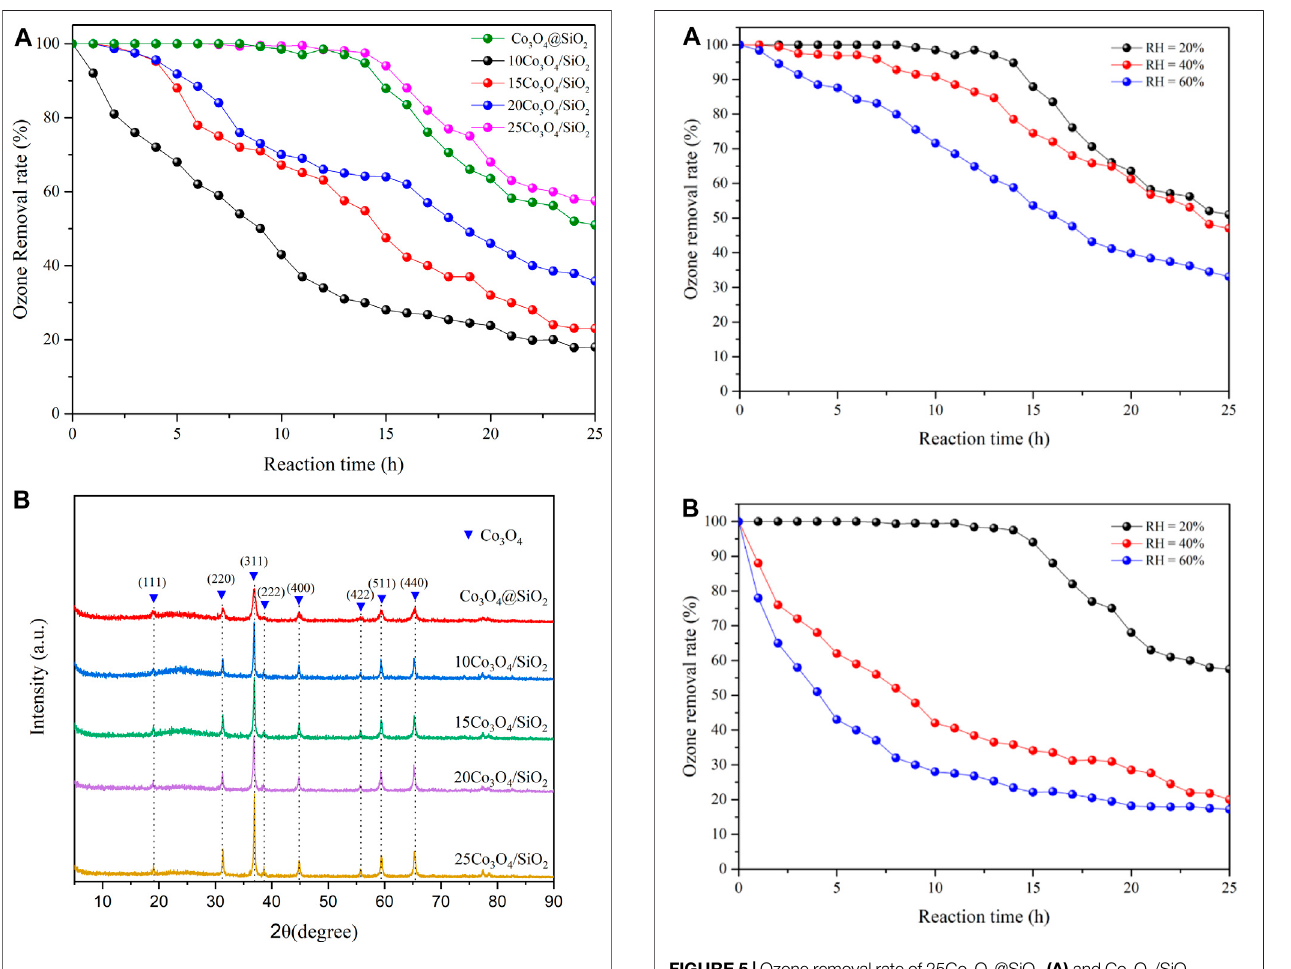
Co 3 O 4 @SiO 2 (68.8 m 2 /g). The speci fi c surface area of a catalyst is